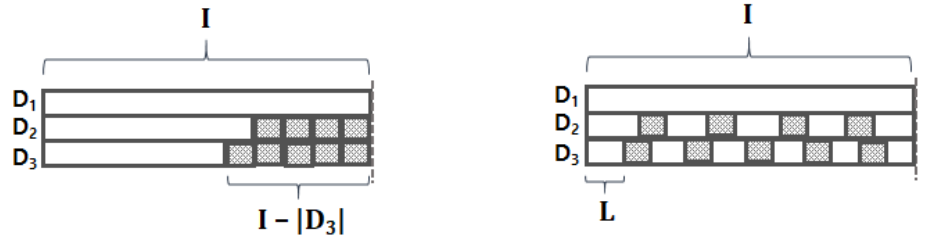
Figure 4. Comparison between two padding methods, where the shaded squares represent padding tokens. ( left ) Conventional padding. ( right ) Stretch